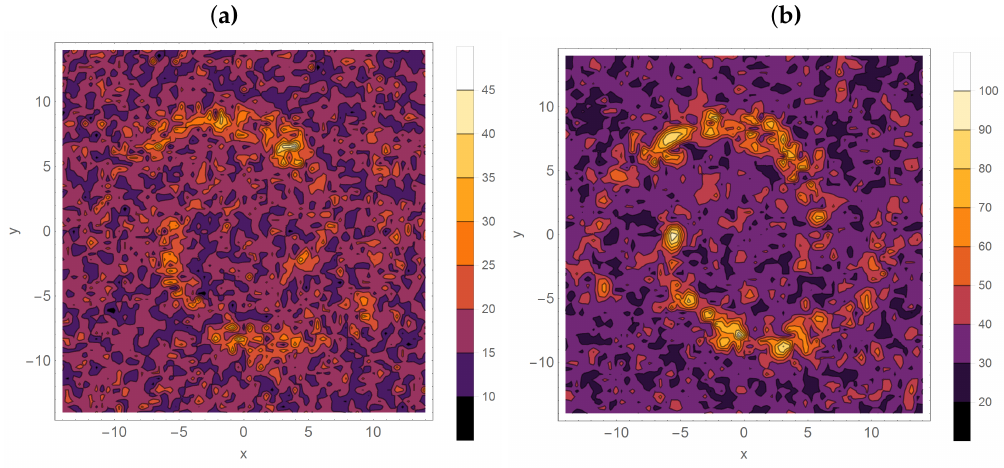
Figure 5. Distributions for a model which consists of large scales, small scales and noise: ( a ) F max , ( b ) w max . Colour scale shows values in µ